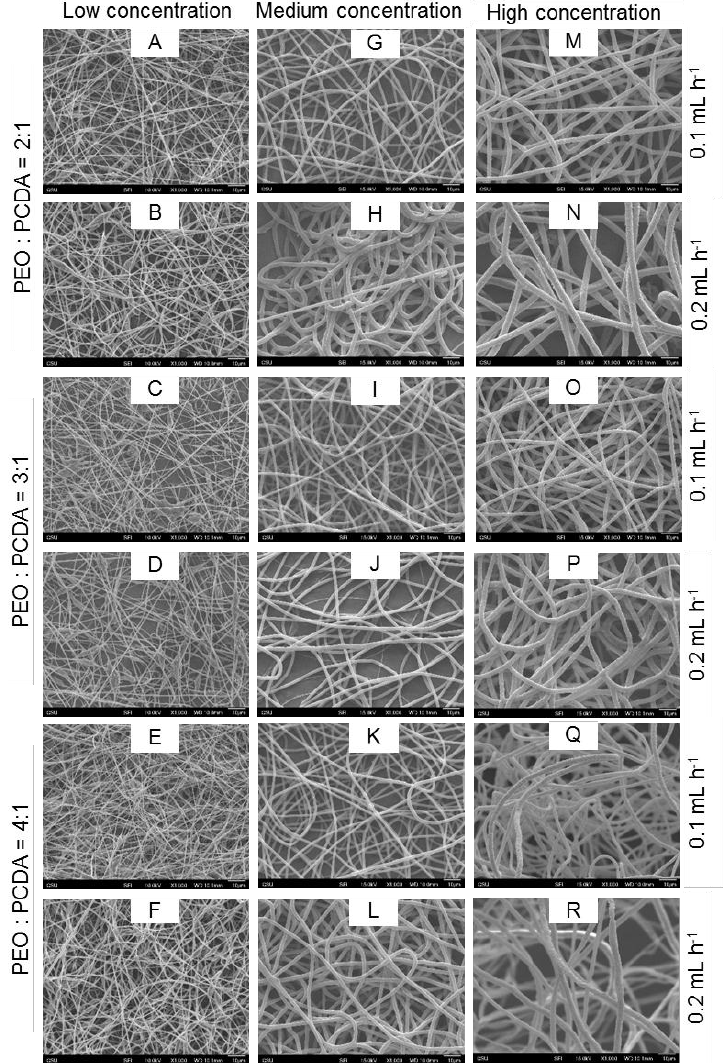
Figure 3. SEM images of PEO-PDA electrospun fibers. Fibers presented in first column (A-F), second column (G-L), and third column (M-R) were prepared at low concentrations, medium concentrations and high concentrations respectively. Respective mass ratio, and injection speed are mentioned respectively at the left and right side of the fiber images. Fibers with beads were prepared at low concentrations (A-F) irrespective of mass ratio of PEO to PCDA. Number of beads were higher at low (0.1 mL·h −1 ) injection speed (A, C, and E) as compared to the high (0.2 mL·h −1 ) injection speed (B, D and F). Smooth fibers were developed with an increase in concentration and injection speed. Colorimetric transition of the PEO-PDA fibers was evaluated after the fibers were heat-treated at a temperature ranging from 25 °C to 120 °C using a spectrophotometer. 18 PEO-PDA fibers